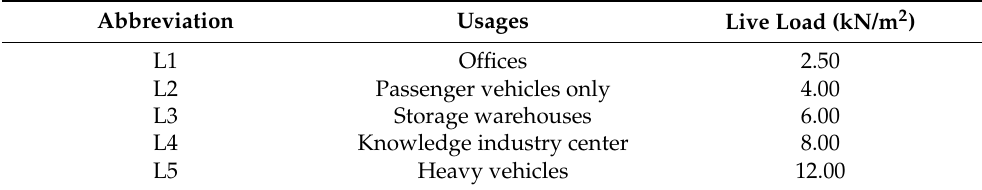
Table 1. Live loads according to the usages of the underground space [44].